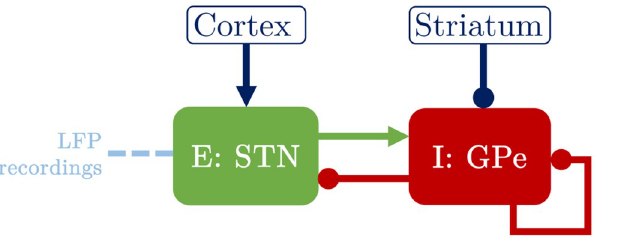
Fig 6. Mapping of the Wilson-Cowan model onto the STN-GPe loop. The excitatory population E and the inhibitory population I model the basal ganglia STN and GPe, respectively. Arrows denote excitatory connections or inputs, whereas circles denote inhibitory connections or inputs. The DBS electrode is implanted in the STN (indicated by a dashed light blue line) and records the STN LFP. The STN also receives an excitatory input from the cortex, while the GPe receives an inhibitory input from the striatum, and also has a self-inhibitory loop.